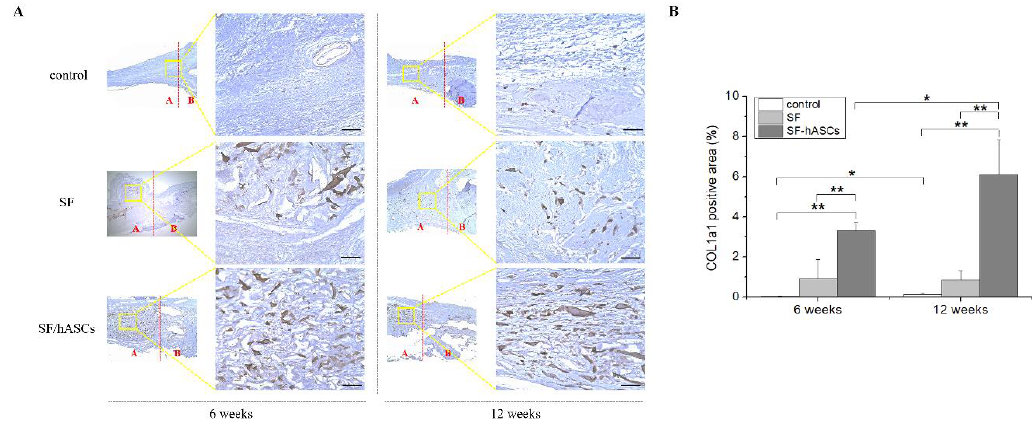
Figure 8. Collagen type I alpha 1 (COL1a1) immunohistochemical (IHC) staining of rat calvarial defects in the control, implanted SF scaffold, and implanted SF-hASCs scaffold groups. ( A ) IHC staining of COL1a1 positive cells at six and twelve weeks postimplantation in the three different groups. ( B ) Semi-quantitative analysis of the relative amounts of COL1a1-positive cells in the three different groups (*, p ≤ 0.05; **, p ≤ 0.01; scale bar = 50 μm; red A and B = defect area and host bone area, respectively).